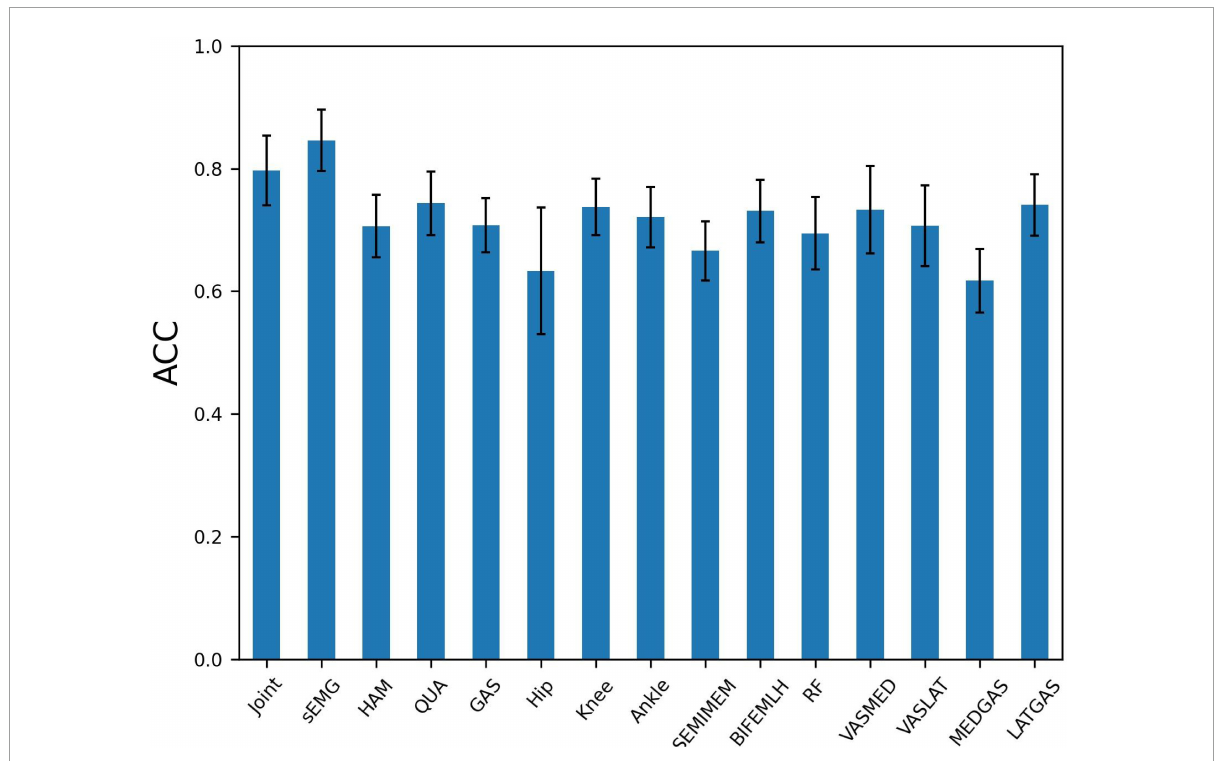
FIGURE7 Patellofemoral pain syndrome (PFPS) classification accuracy for different node input information selection strategies: Joint, the joint angles of Hip Flexion, Knee Flexion, and Ankle Flexion when subjects in running; sEMG, the sEMG signals of 7 muscles in the dataset; HAM, hamstrings’ sEMG, including BIFEMLH and SEMIMEM; QUA, quadriceps’ sEMG, including RF, VASMED and VASLAT; GAS, gastrocnemius’ sEMG, including MEDGAS and LATGAS.